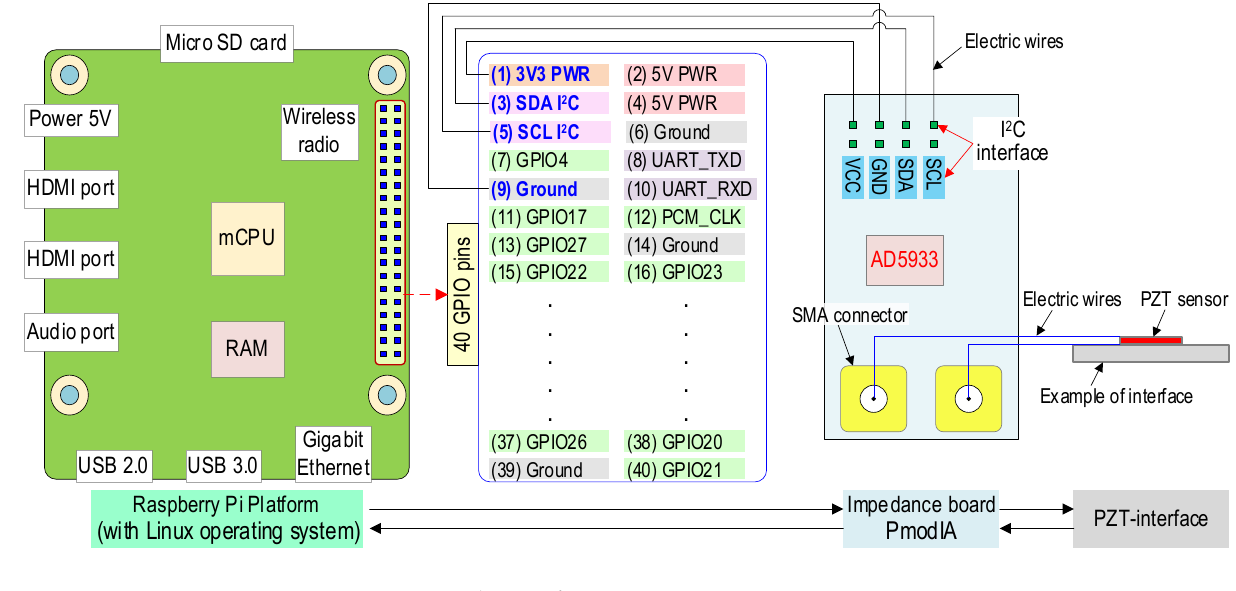
Figure 3. Circuit design of ‘ SSeL-Pi ’ .